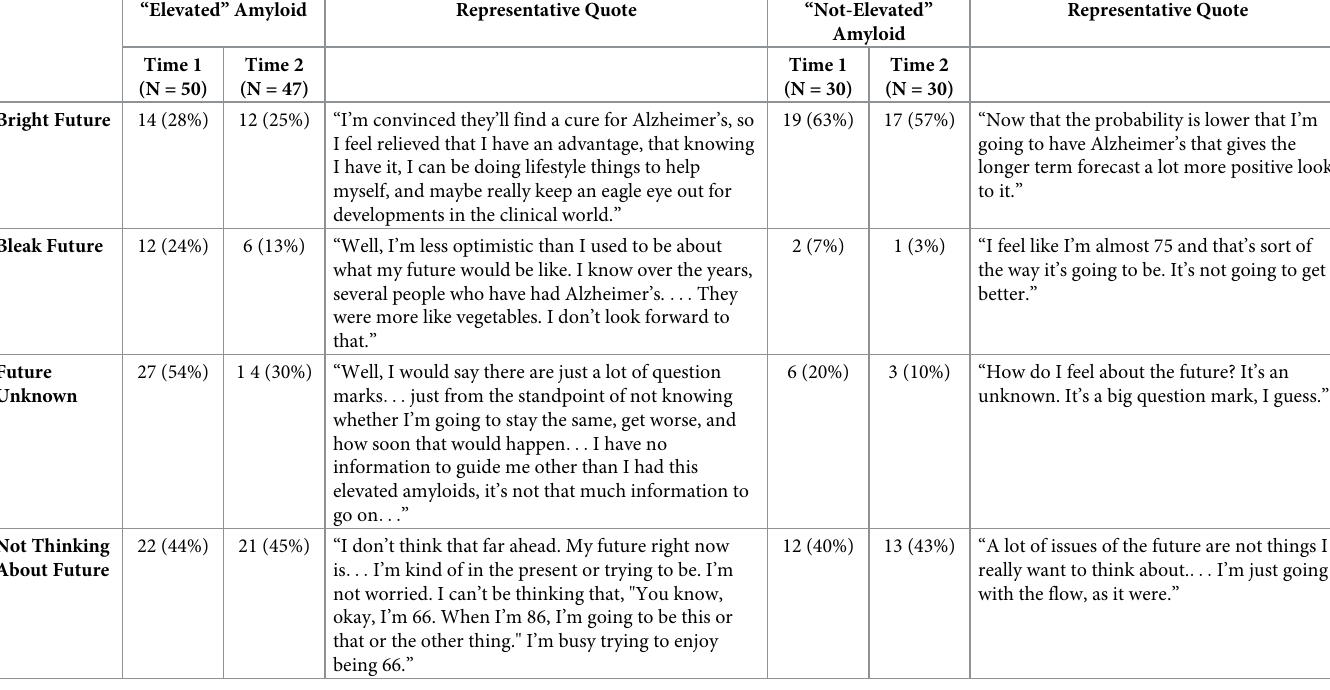
Table 2. Responses to the questions “How do you feel about your future?” and “Did you feel the same way before you learned your amyloid PET scan result?/ How did learning your result change how you feel about your future?” a . “Elevated” Amyloid Representative Quote “Not-Elevated”